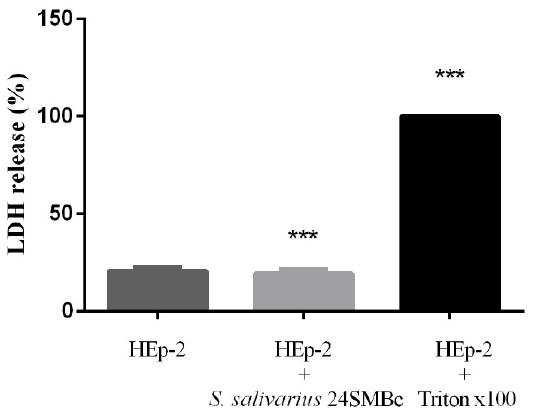
Figure 4. Levels of LDH release to evaluate the cytotoxic effect with S. salivarius 24SMBc. HEp-2 alone as 0% LDH release, HEp-2 plus S. salivarius 24SMBc, and HEp-2 cells plus Triton X-100 as a control of total release (100% LDH release). Statistically significant p value: *** p < 0.001.